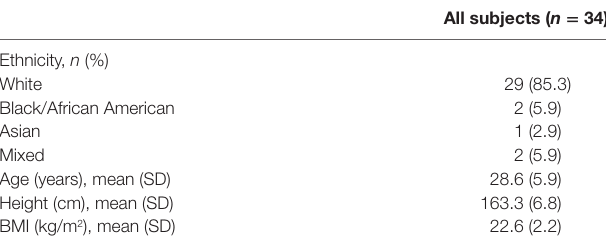
TaBlE 1 | Baseline